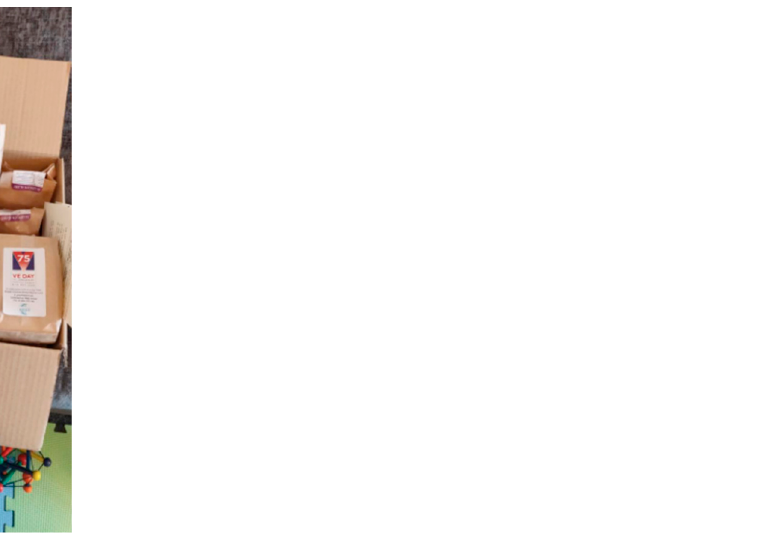
Figure 10. George’s packages of cakes to deliver to the elderly on VE day (George, Diary Image 14).